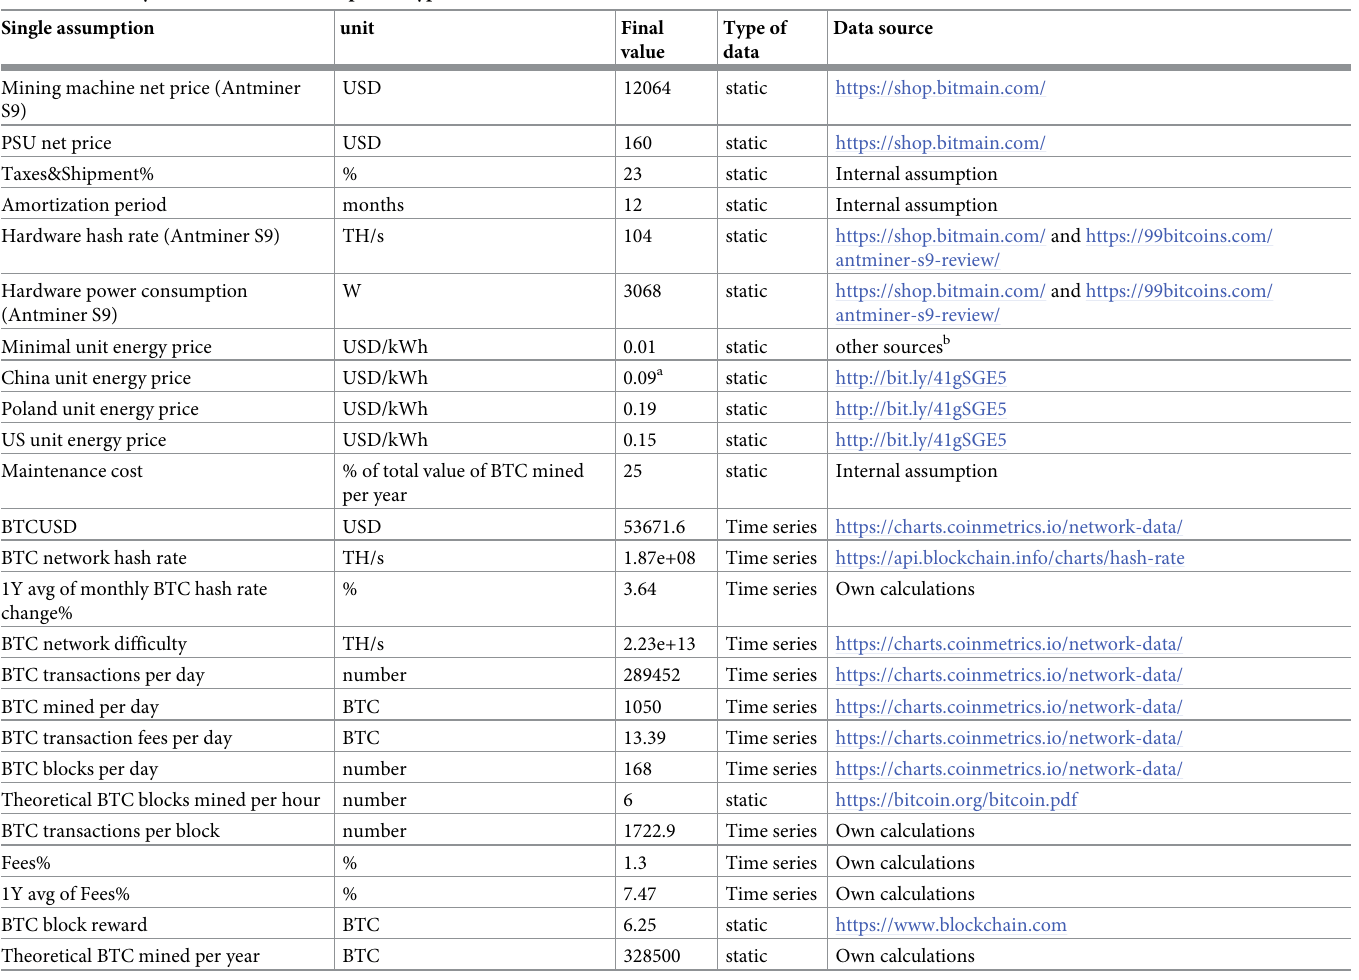
Table 2. Summary of all our crucial assumptions, types of data, and data